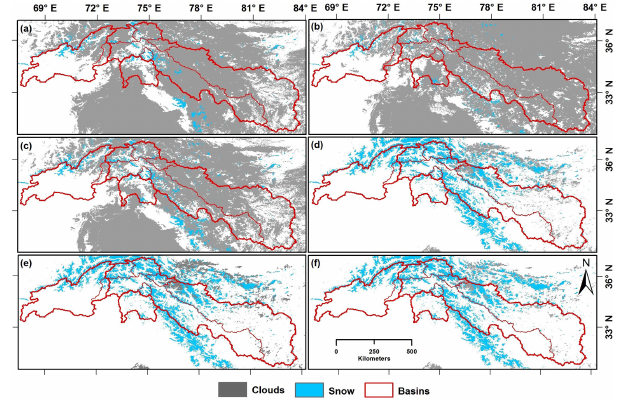
Figure 7. Cloud and snow cover of original MODIS Terra and Aqua Images and after implementation of five steps for day 144 of year 2004, (a) original MODIS Terra, (b) original MODIS Aqua, (c) af- ter combining Terra and Aqua, (d) after temporal filling, (e) after spatial filling, and (f) after temporal